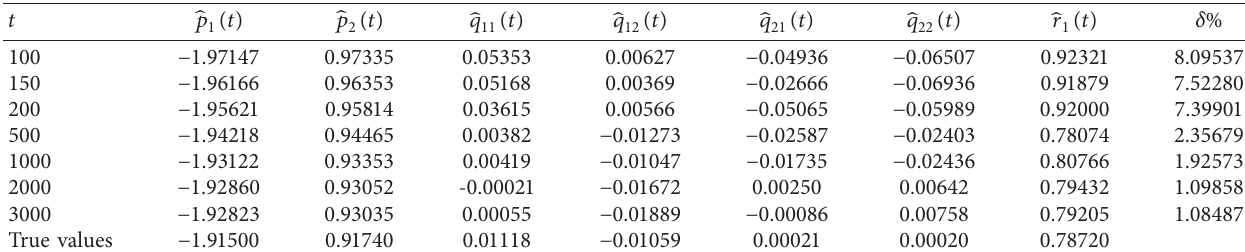
Table 4: The parameter estimates and their errors with recursive extended least squares algorithm ( σ 2 � 0 . 40 2 ).